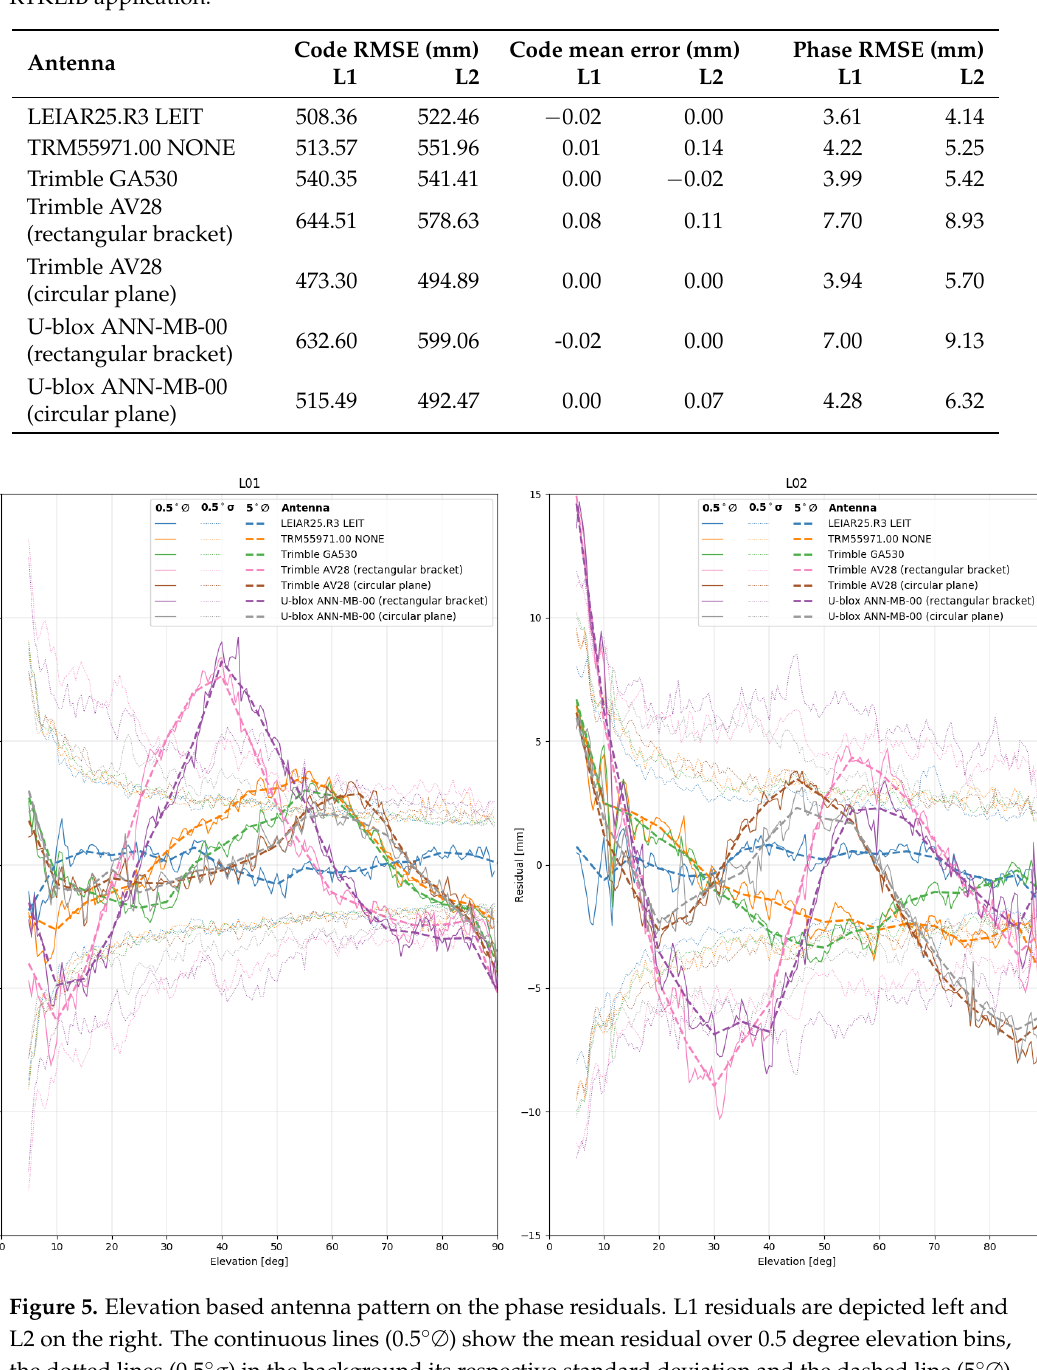
Table 4. Mean and Root Mean Square Errors (RMSE) of code and phase residuals from the static solutions of the short baseline experiments. The phase mean is zero for all antennas since the mean of the single-differenced residuals are used as reference for the DD analysis in the modified RTKLIB application.